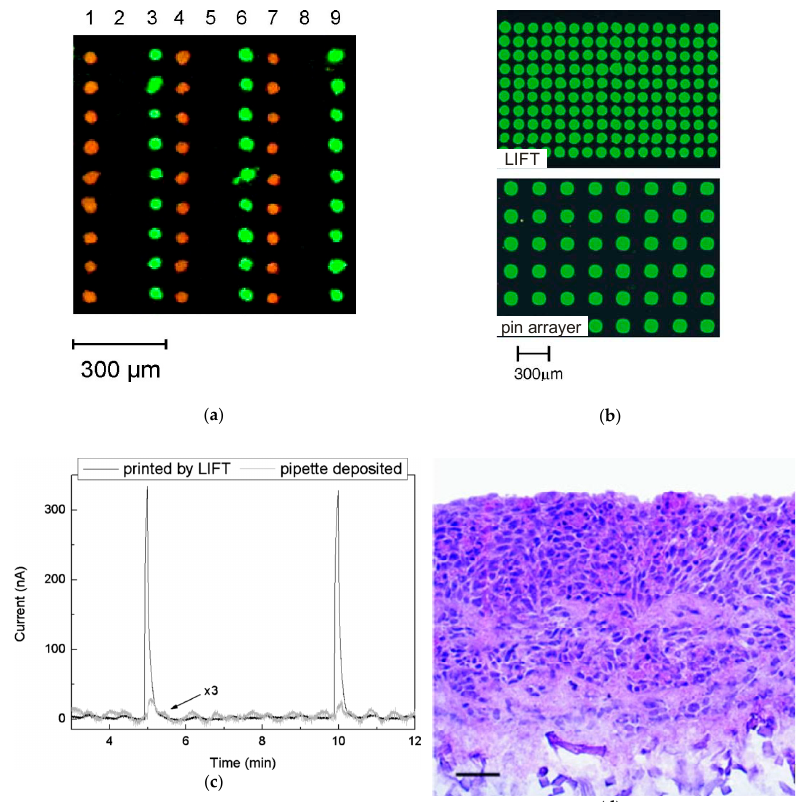
Figure 6. ( a ) Fluorescence image of a microarray of two different cDNA strands printed by LIFT after hybridization with green and red tags. DNA-free solution was printed in columns 2, 5, and 8. Reprinted from [82] with permission of AIP Publishing. ( b ) Images from fluorescence scanners of microarrays of the same cDNA solution printed through LIFT (top) and commercial pin microspotting arrayer (bottom). Similar fluorescence signals are recorded after hybridization with complementary cDNA strands tagged with Cy3 fluorochrome. Reprinted and partially adapted from [83] with permission of Elsevier. ( c ) Comparison of amperometric signals for gold screen printed electrode sensors printed by LIFT (black line) and by pipette spotting method (gray line). Reprinted from [90] with permission of AIP Publishing. ( d ) Printed cells structure mimicking skin. Twenty layers of murine fibroblasts and twenty layers of human keratinocytes embedded in collagen were printed by LIFT. Scale bar is 50 μ m. Reprinted from [109] with permission of John Wiley and Sons.